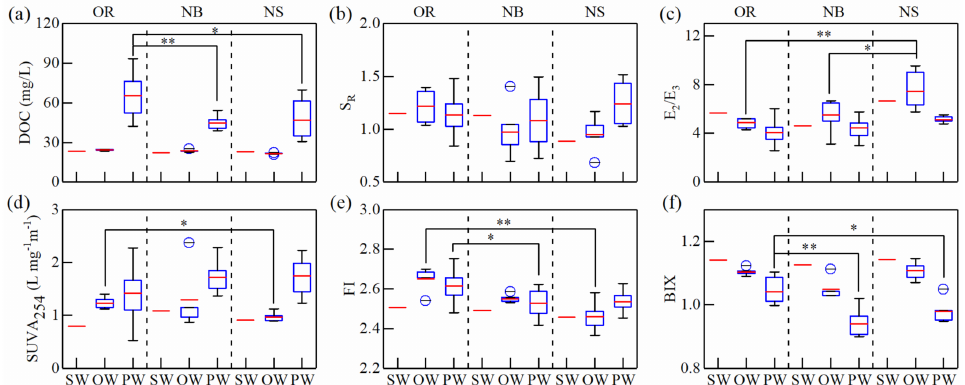
Figure 2. Box plots of ( a ) DOC concentrations; ( b ) S R : spectral slope ratio; ( c ) E 2 /E 3 : absorption ratio; ( d ) SUVA 254 : specific UV absorbance at 254 nm; ( e ) FI: Fluorescence index; ( f ) BIX: biological index) in SW, OW and PW from three sampling sites (OR, NB and NS). The symbols * and ** show significant differences at p < 0.05 and p < 0.01,